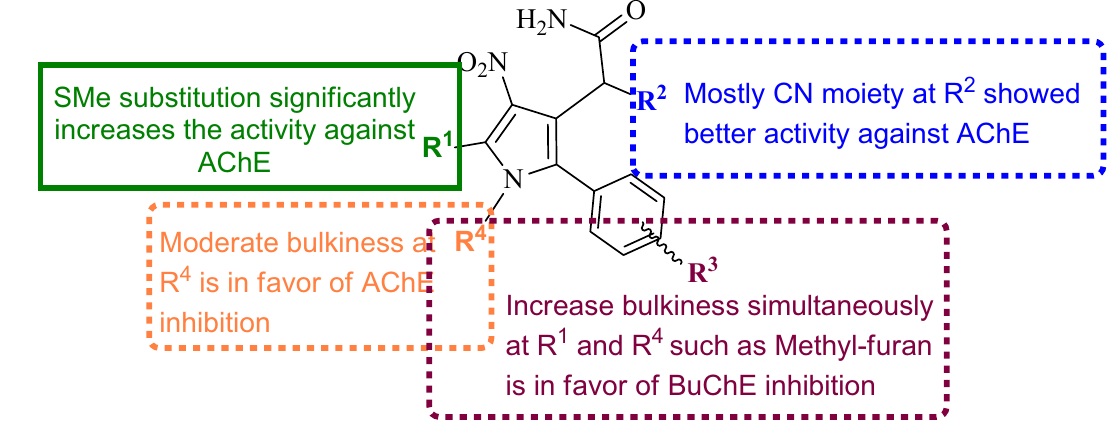
Figure 6. Summary of SARs of polysubstituted pyrroles as ChEs inhibitors.